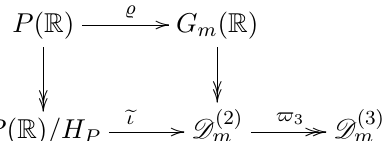
Figure 2 . The diagram of the Klein geometries for the example P ( R ) = E The white/black color speci(cid:12)es the particular real form of the Lie group E 7 , the lozenge stands for the highest weight of the representation % . Since % corresponds to the black node, which is an extension node, H (3) (cid:26) E is a maximal compact subgroup, so D (3) 7( (cid:0) 25) E 7( (cid:0) 25) special geometry, is locally